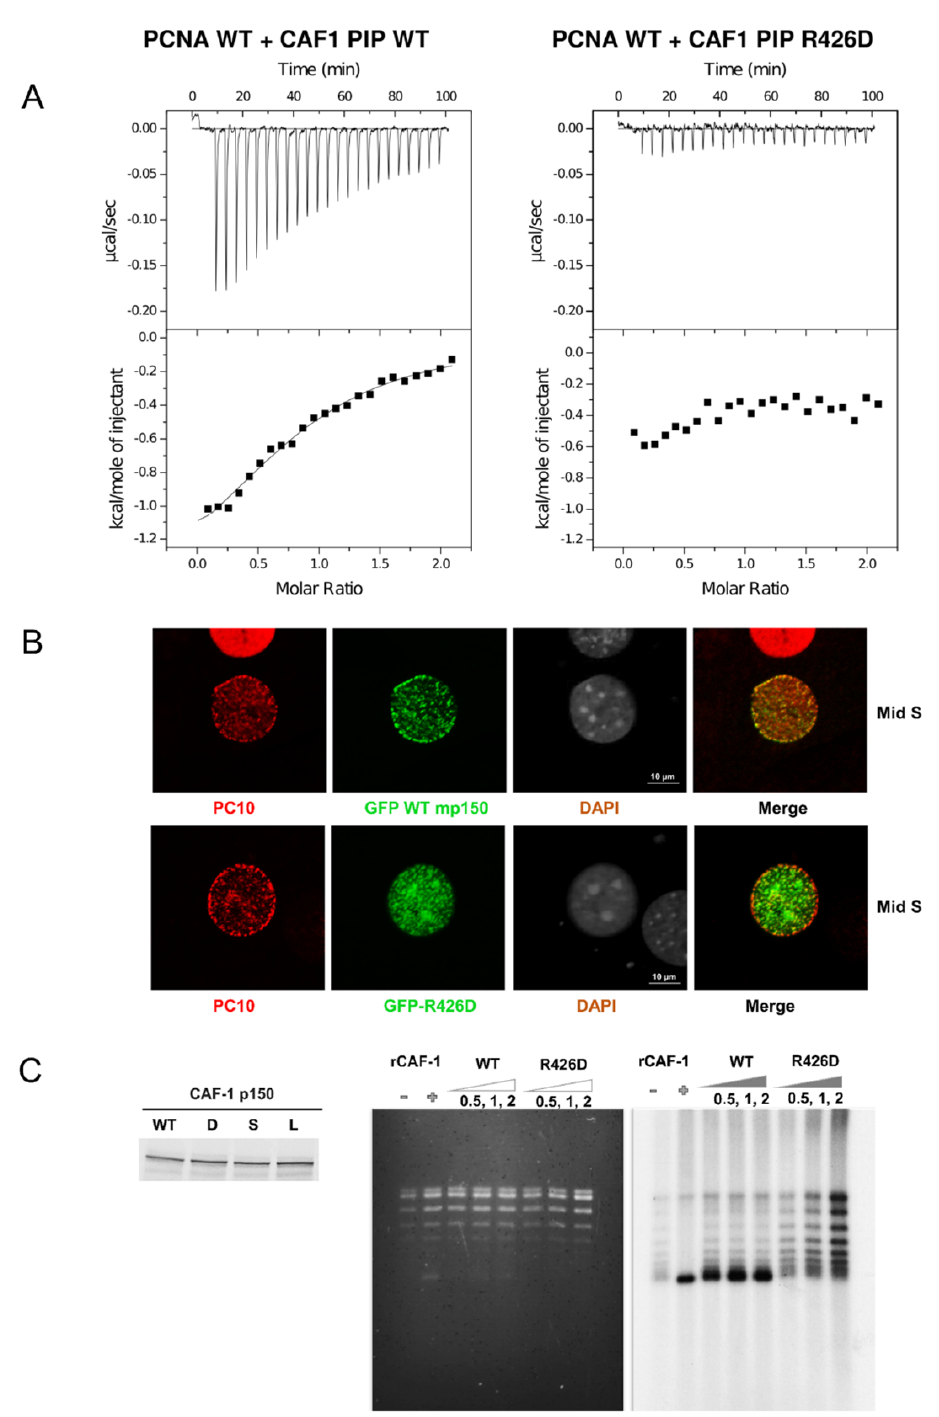
Figure 4. Cellular and molecular consequences of the PIP-Arg 426 mutation. ( A ) In ITC experiments, the CAF-1 PIP wild-type and R426D substituted peptides were progressively titrated into a sample cell containing PCNA. The upper half of each panel shows the measured heat exchanges following each peptide injection. The lower half of each panel shows the enthalpic changes as a function of the molar ratio of peptide to PCNA monomer. The black squares correspond to individual injections. Titrations were performed in 10 mM sodium phosphate, pH 7.0, 10 mM NaCl, and at 23 °C. ( B ) The Arg426 mutation causes mis ‐ localization of mouse p150 (mp150) in mid S ‐ phase cells. Mouse NIH3T3 cells were transduced with constructs for expression of GFP CAF1 p150 WT or R426D mutant and stained with the PC10 monoclonal antibody (PC10) against PCNA to detect DNA replica ‐ tion foci. The mis ‐ localization of the R426D mutant is most evident in mid S ‐ phase cells, where the red PCNA staining is, in part, localized to the periphery of the cell nucleus, whereas the green CAF ‐ 1 p150 R426D is more localized to the pericentric heterochromatin (large foci seen with DAPI stain ‐ ing). ( C ) Arg426 is required for nucleosome assembly during SV40 DNA replication. Left panel: CAF1 p150 wild ‐ type and R426D mutant proteins were expressed in the rabbit reticulocyte lysate in the presence of [ 35 S] ‐ methionine and detected by SDS ‐ PAGE and autoradiography. Middle panel: Total DNA from nucleosome assembly reactions was stained with ethidium bromide. rCAF ‐ 1 is purified full ‐ length recombinant CAF ‐ 1 added as a positive control. Right panel: Nucleosome as ‐ sembly reactions were performed in the presence of increasing amounts of wild ‐ type p150 PIP or R426D mutant. Replicated DNA was detected by incorporation of [ α‐ 32P] dATP and autoradiog ‐ raphy. Lane 1 corresponds to a negative control reaction lacking p150 where there was very little supercoiling observed. In contrast, we did not observe any heat exchange when we used the CAF ‐ 1 PIP R426D peptide (Figure 4A and Table 2). This suggests that the R426D substitution severely abrogates binding to PCNA. This interpretation is consistent with several other lines of evidence described below. We mutated the PCNA tyrosine involved in the cation ‐π inter ‐ action with CAF ‐ 1 p150 Arg426. The resulting mutant, PCNA ‐ Y250I was expressed and purified from E. coli . Based on size exclusion chromatography, there was no evidence of aggregation that might suggest inappropriate folding of PCNA ‐ Y250I. The wild ‐ type PIP was then titrated into PCNA ‐ Y250I, and there was no detectable heat exchange observed by ITC (Supplementary Figure S1). Taken together, the results obtained with the PIP R426D and the PCNA ‐ Y250I mu ‐ tants were consistent with the cation ‐π interaction observed in the crystal model. 2.2.2. Arginine 426 Is Important for Targeting CAF ‐ 1 to DNA Replication Foci Containing PCNA We next evaluated whether the wild ‐ type CAF ‐ 1 p150 and the R426D mutant localize to replication foci containing PCNA. Previous research from several laboratories has doc ‐ umented stereotypical patterns of PCNA foci that are characteristic of the different stages of S ‐ phase [29 ‐ 31]. Cells in early S ‐ phase show numerous small PCNA foci distributed throughout the nucleus. These foci can be resolved from each other using super ‐ resolution microscopy